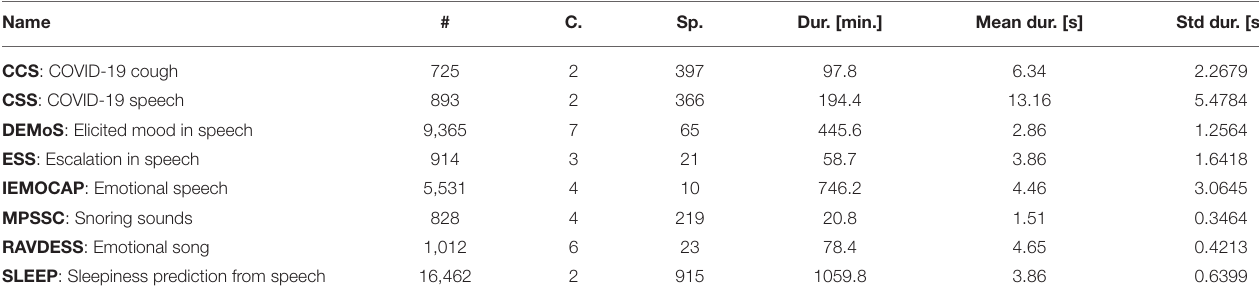
TABLE 1 | Statistics of the databases utilized in our experiments in terms of number of samples ( # ), number of speakers ( Sp. ), number of classes ( C. ), total duration ( Dur. ) in minutes, and mean and standard deviation of the duration ( Mean & Std dur. ) in seconds.